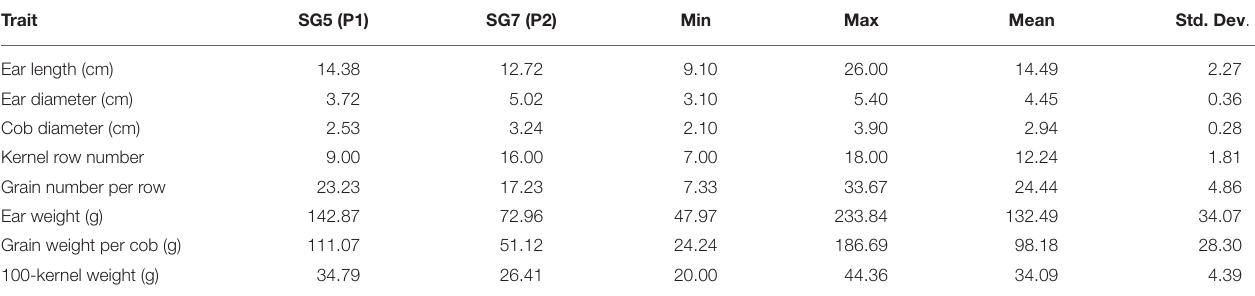
TABLE 3 | Pearson correlations for yield related traits of maize from the F 2 population of SG5 × SG7. Trait EAL EAD CD KRN EAL EAD CD 0.033